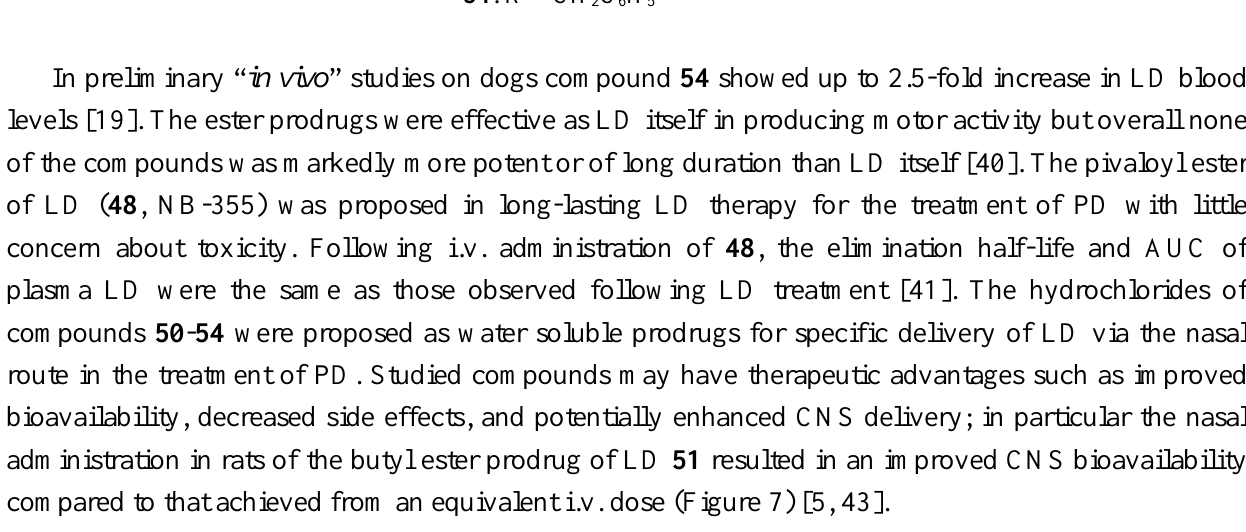
Figure 7 . Kinetic model of LD prodrugs following the nasal administration as proposed by Kao et al .